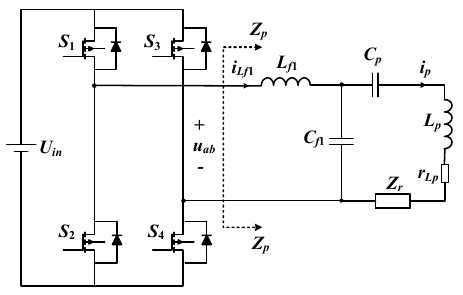
Figure 2. Inductor-capacitor-capacitor (LCC) compensation network in the primary